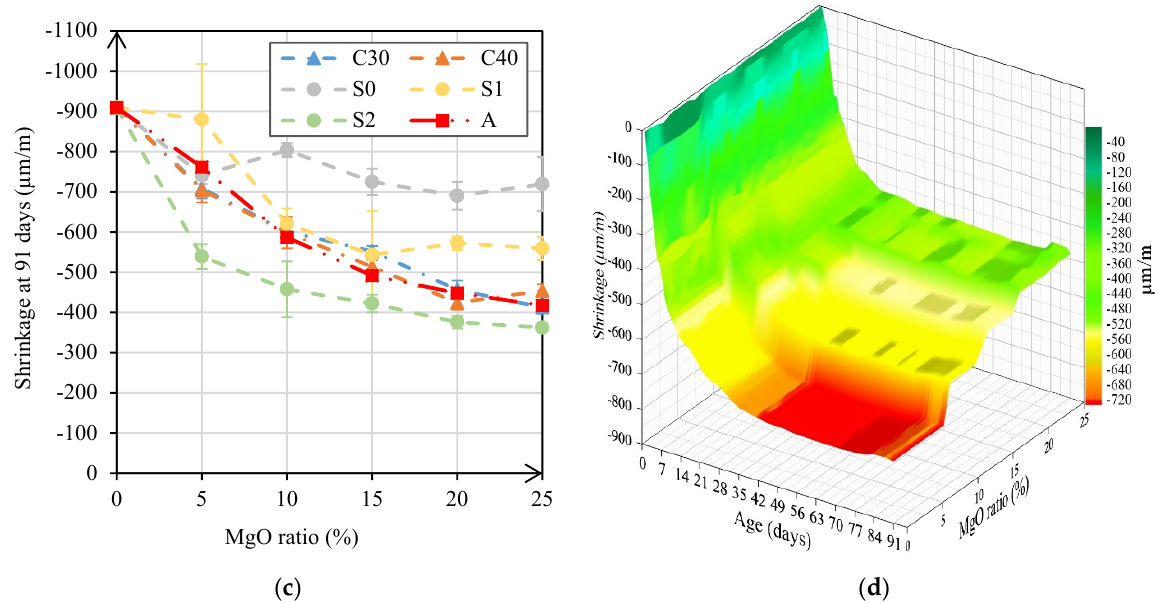
Figure 11. Shrinkage at 7 days ( a ), 28 days ( b ), and 91 days ( c ) versus MgO content; shrinkage over time versus incorporation ratio of MgO ( d ).